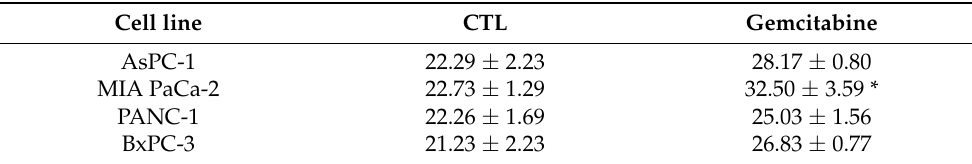
Table 3. Percentages of cell in S phase after control (CTL) and gemcitabine (10 nM) for AsPC-1, BxPC-3, MIA PaCa-2 and PANC-1cell lines. * p < 0.05 (vs.